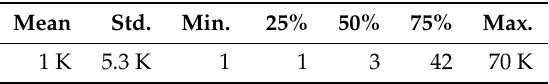
Table 3. Percentiles for the distribution of how many times a property is used in the knowledge graph. 75% of the properties are used only 42 times. We discard rare movie attributes, and only focus on Starring, writer, genre, director, and producer.